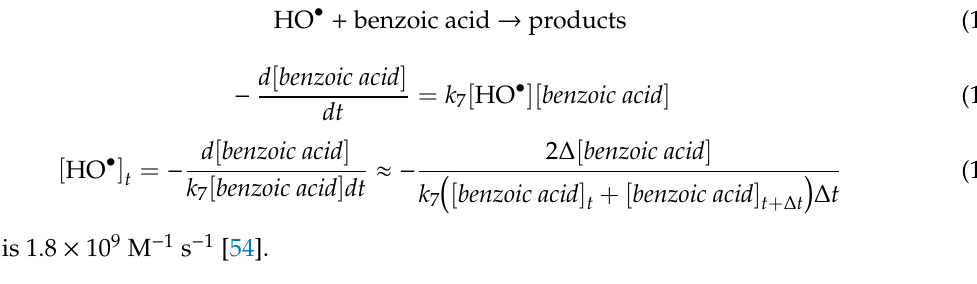
Figure S1: Schematic representation of used reactor at ( a ) top view and ( b ) side view. a , 2.5 cm; b , 3.5 cm; h , 7 cm, Figure S2: Maps of used plasmids in this study to endow corresponding antibiotic resistance, Figure S3: E. coli inactivation by ( a ) electrolysis, MOPS bu ff er or thiourea, ( b ) hydrogen peroxide, ( c ) iron ions, and ( d ) acidic pH, Figure S4: Electro-Fenton process disinfection performance towards E. coli of di ff erent antibiotic-resistances including control experiments during 60